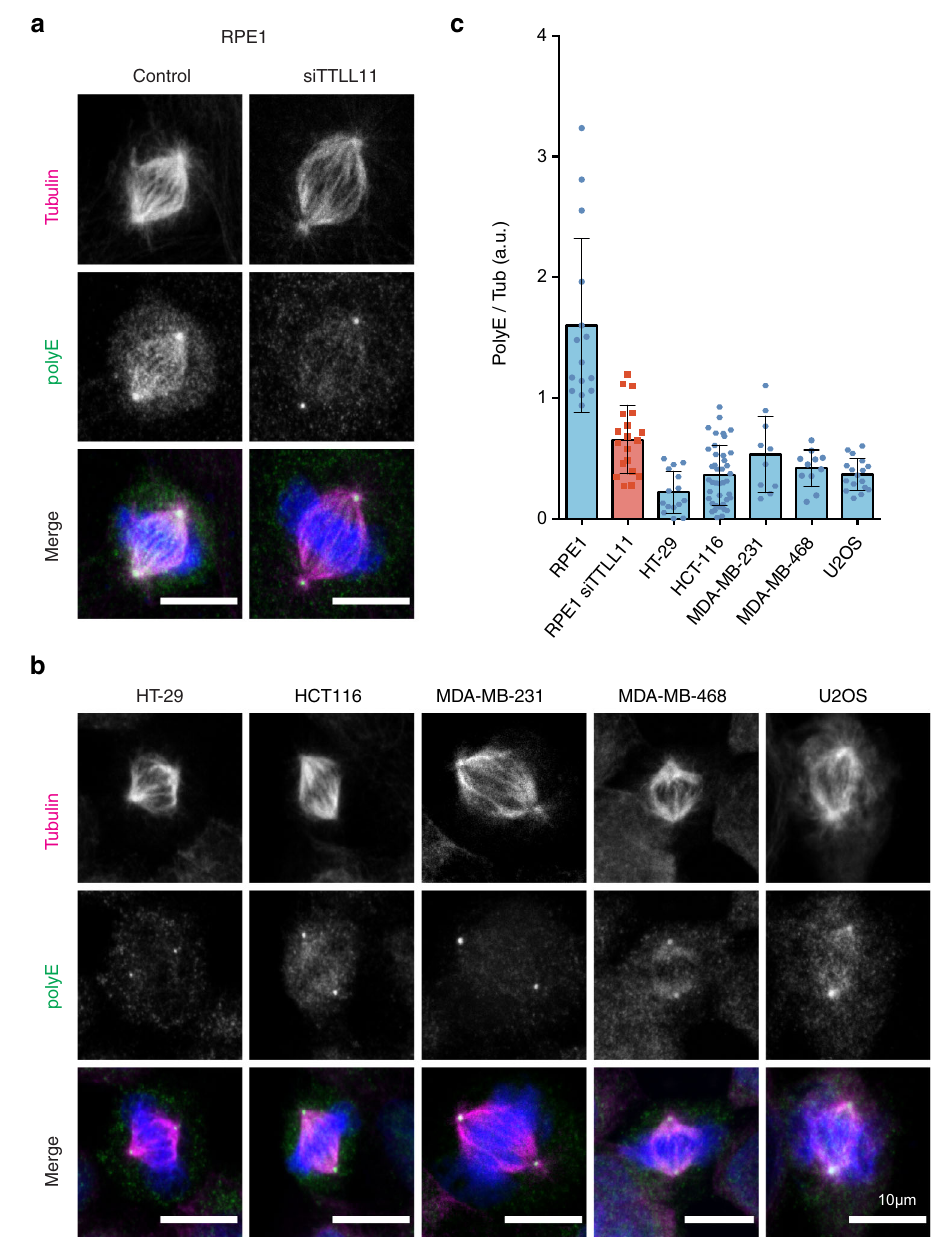
Fig. 5 | Spindle MT polyglutamylation levels are reduced in cancer cells. a Immuno fl uorescence images of metaphase spindles in control and siTTLL11 hTERT-RPE1 untransformed cells, showing the PolyE signal (green), tubulin (red) and DNA (blue). Scale bars, 10 μ m. b Immuno fl uorescence images of metaphase spindlesinapanelofcancercelllinesasindicated.ThePolyEsignal(green),tubulin (red), and DNA (blue) are shown. Scale bars, 10 μ m. c Quanti fi cation of the polyE